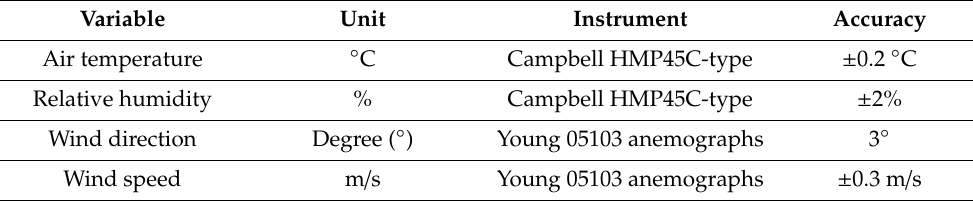
Table 2. Measured meteorological variables, instruments, and sensors’